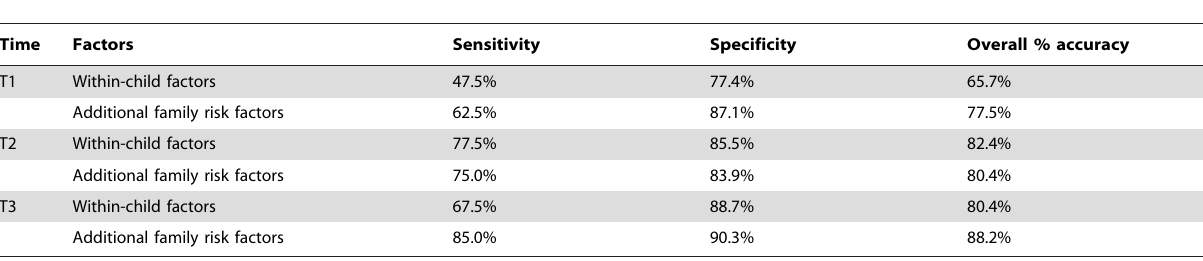
Table 6. Classification accuracy using within-child and family risk